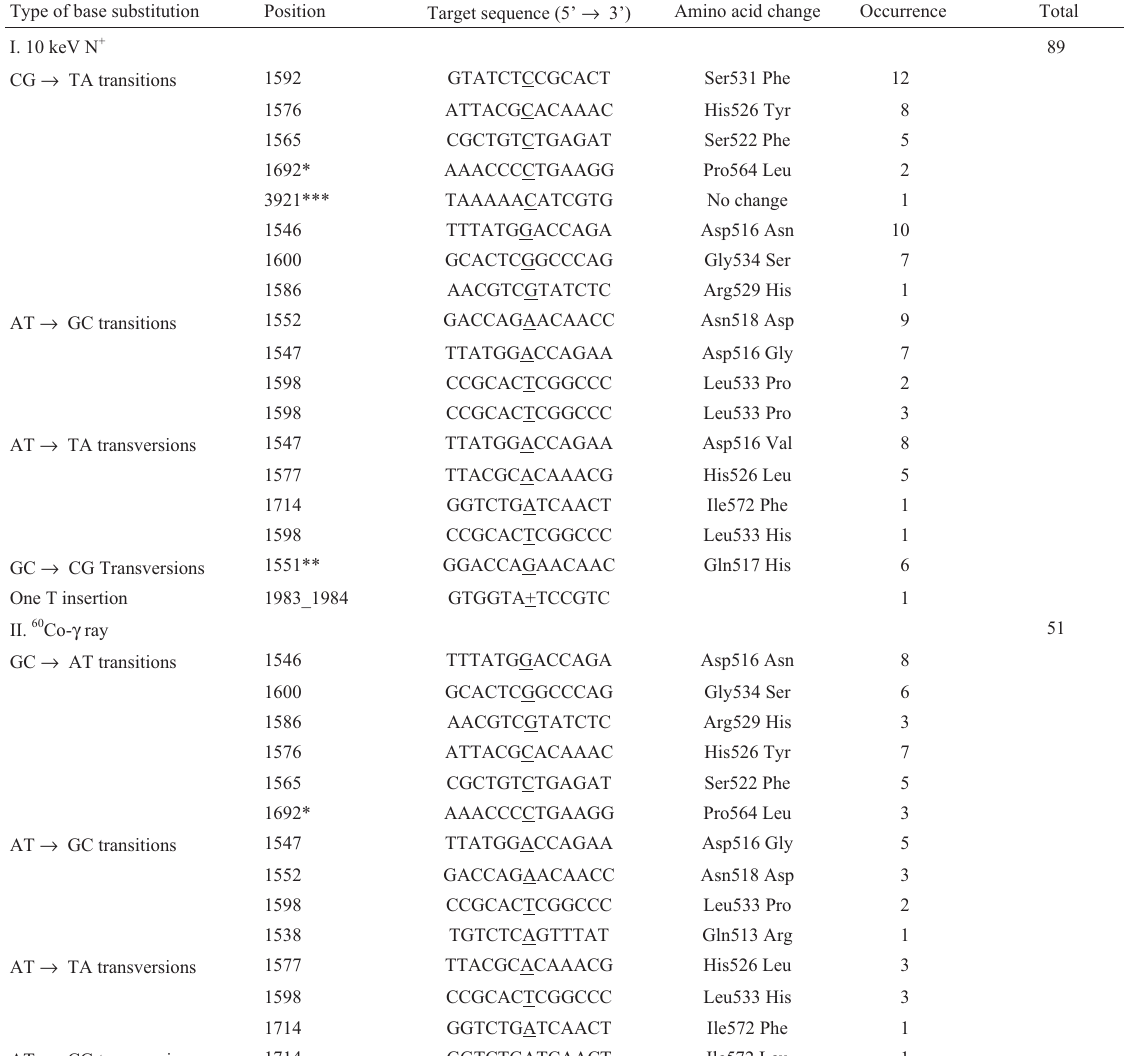
Table 2 - Distribution of specific types of base substitutions and relative